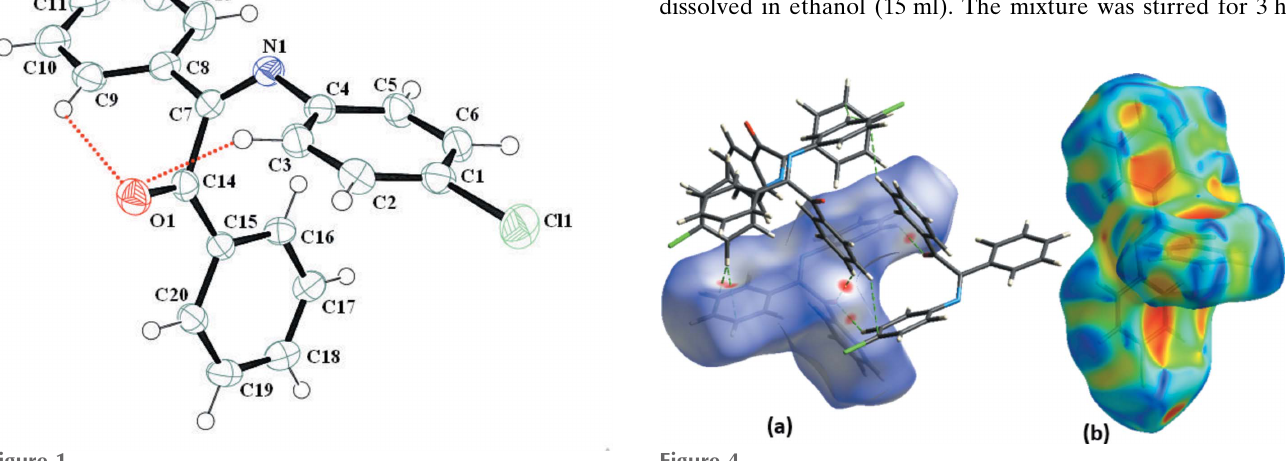
Figure 1 The title molecule with the labelling scheme and 50% probability ellipsoids. Dashed lines indicate the intramolecular hydrogen bonds.